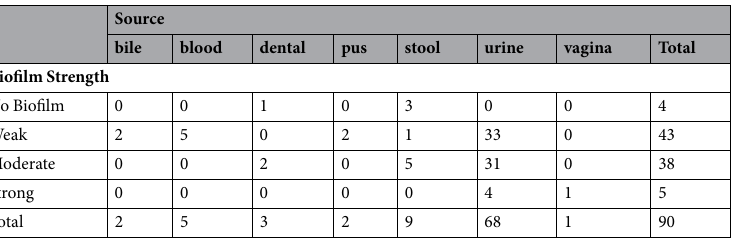
Table 1. Association between biofilm-forming strength and specimen origin. Chi-square = 58.03 (with 18 degrees of freedom); P ≤ 0.0001.